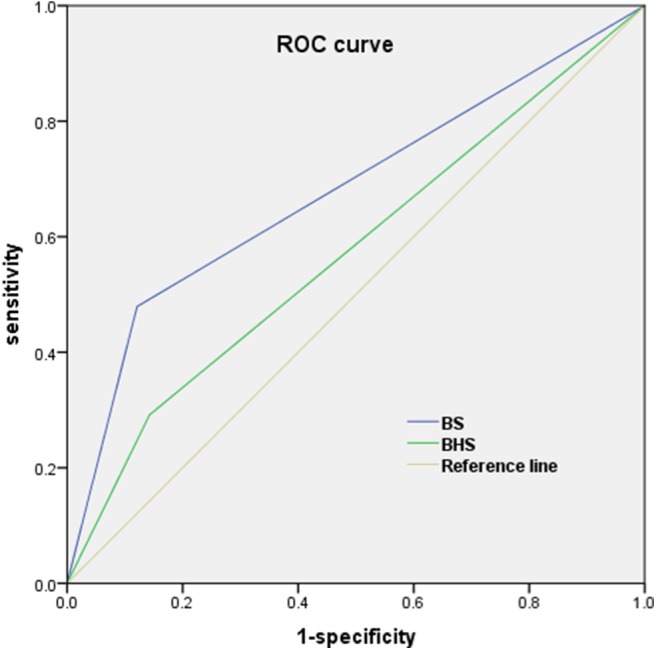
The receiver operating characteristic (ROC) curve of the BS and BHS were used for predicting HE (>12.5 ml). The area under the curve for the BS was 0.67 and that for the BHS was 0.57. BHS, black hole sign; BS, blend sign.